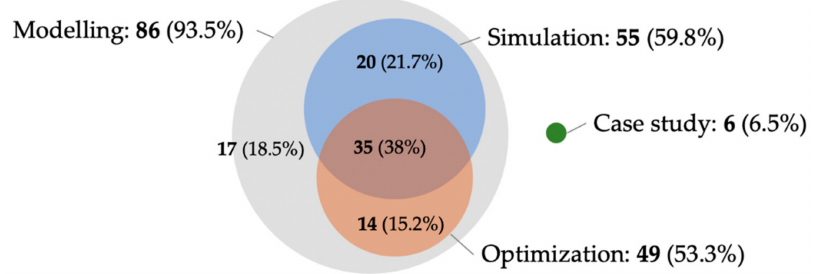
Figure 8. Number of papers using each method and associated